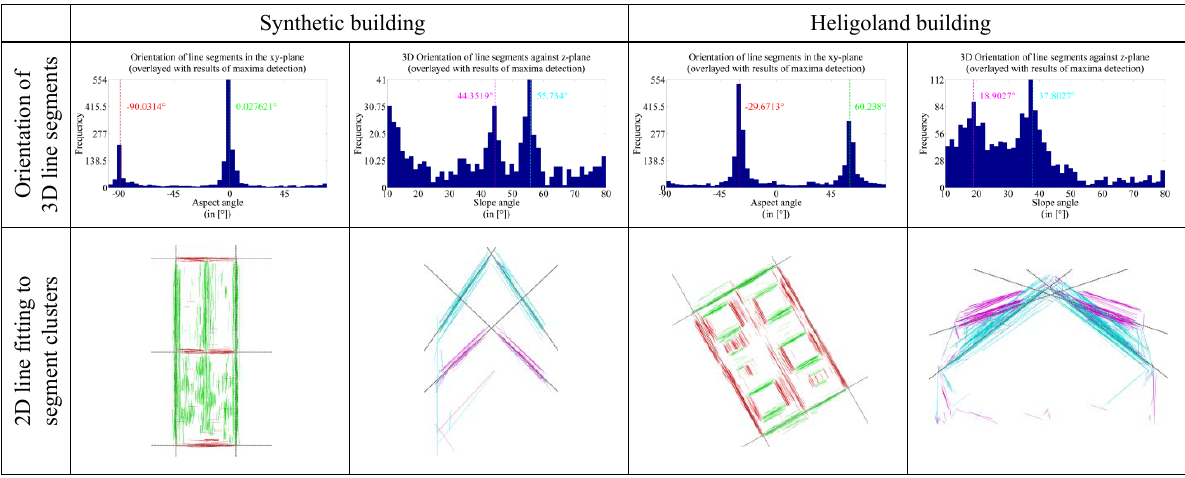
Table 1. Determination of orientation and position of planes (black lines) through clusters of line